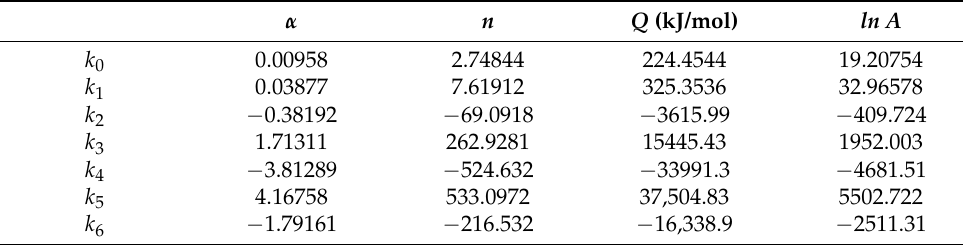
Table 3. Polynomial fit coefficients of α , n, Q , and ln A for the Ti − 6554 alloy of the β phase.